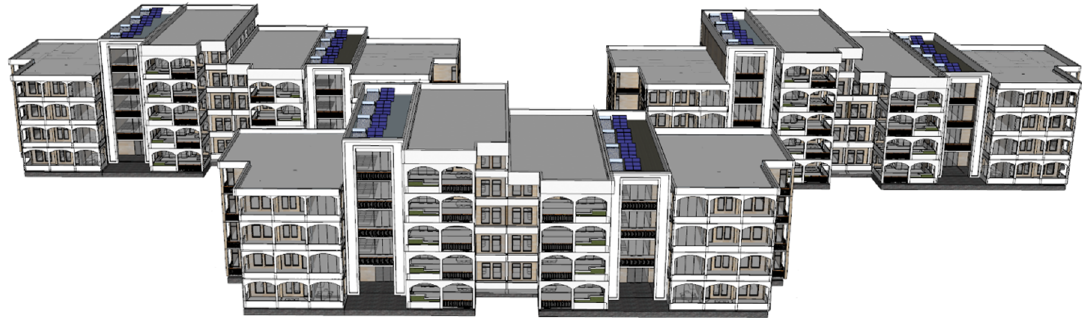
Figure 6. Example of building models designed in the SketchUp software.